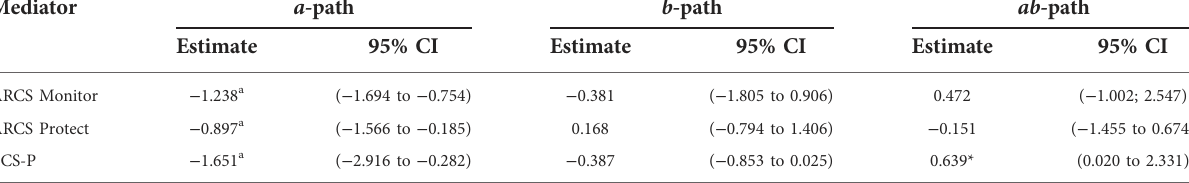
TABLE 4 Unstandardized estimates from the parallel process mediation